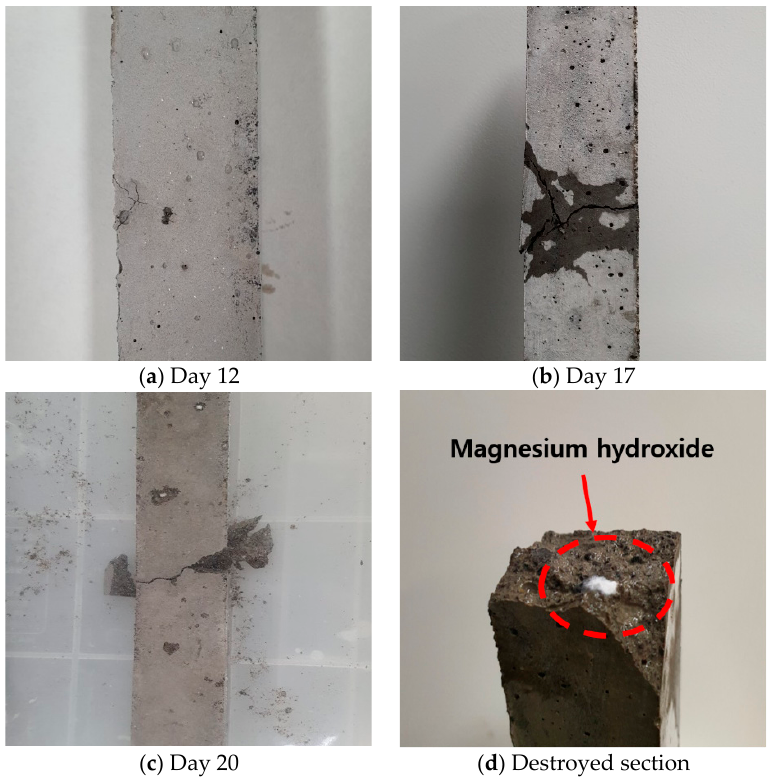
Figure 9. Destruction process during expansion test of mortar bar using converter slag as fine aggregate .